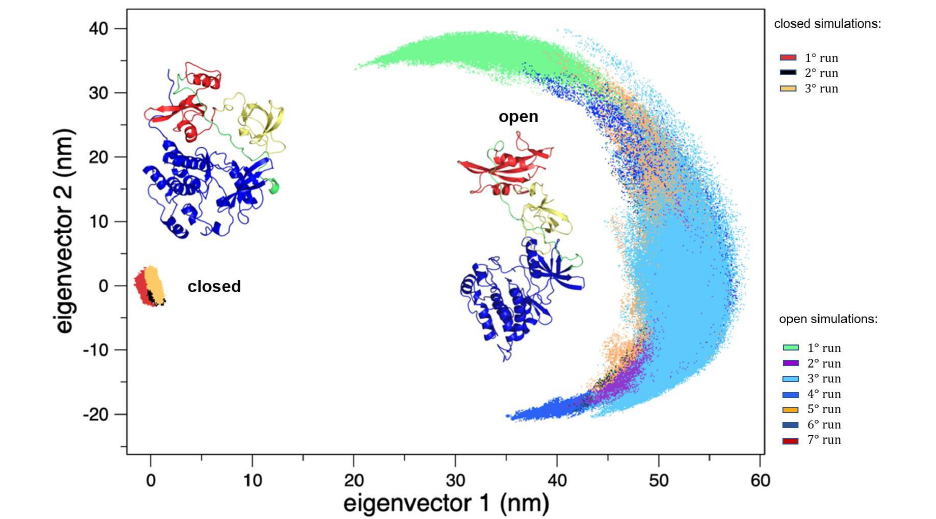
Figure 3. The 2D trajectory projections on the common conformational space. On the left, the region explored by the closed states, and on the right the region explored by the open states. The structures of both the forms are reported as the